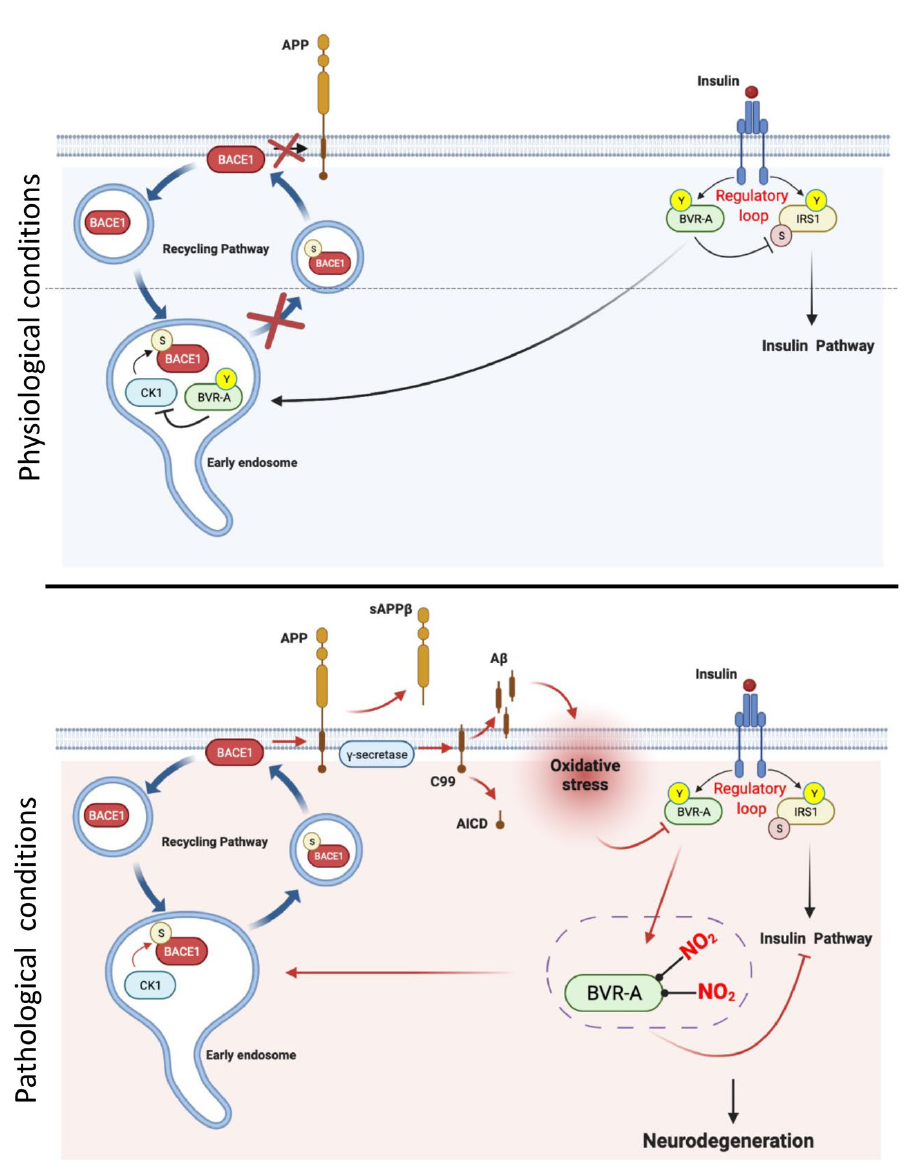
Figure 2. Hypothesized mechanism through which impairment of BVR-A links brain insulin resistance with increased A β production in Alzheimer disease (AD). Under physiological conditions insulin receptor (IR) phosphorylates biliverdin reductase-A (BVR-A) on tyrosine (Y) residues promoting BVR-A kinase activity and scaffold functions. Through these activities BVR-A regulates the activation of insulin signalling. Moreover, BVR-A activation plays a critical role in the inhibition of beta secretase 1 (BACE1) recycling to the plasma membrane. The proposed path probably occurs at the level of the early endosomes where casein kinase 1(CK1)-mediated Ser phosphorylation of BACE1 favors BACE1 recycling to plasma membrane. Under physiological conditions, BVR-A inhibits CK1 activity, thus preventing the phosphorylation of BACE1 and the subsequent recycling at plasma membrane. Conversely, during the progression of Alzheimer disease (AD) pathology the increase of oxidative stress leads to reduced BVR-A Tyr phosphorylation and increased BVR-A nitration (3-NT) that (1) impairs the activation of the insulin signalling pathway and in parallel (2) promotes CK1-mediated BACE1 recycling at the plasma membrane, where BACE1 cleaves amyloid precursor protein (APP), leading to increased beta amyloid (Aβ) production. In turn, as in a vicious cycle, increased Aβ oligomers trigger the elevation of oxidative and nitrosative stress levels, which further impair BVR-A. Arrows: activation; lines: inhibition. Red arrows/lines, molecular pathways activated during AD.